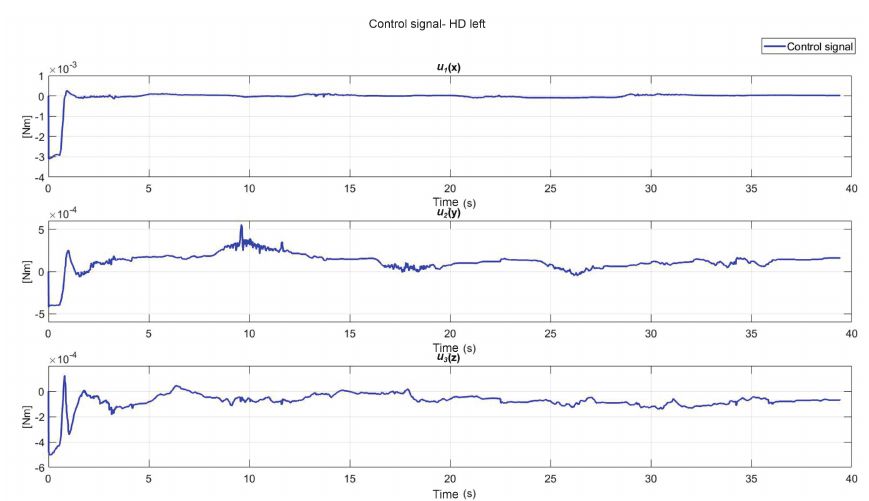
Figure 22. Left haptic device control signal: exercise